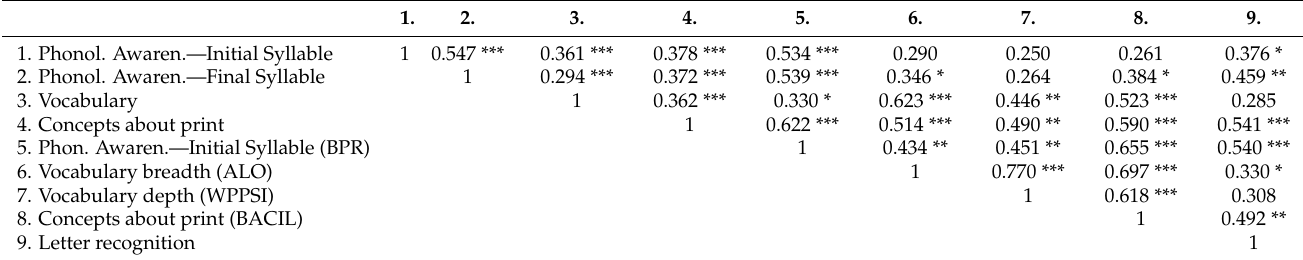
Table 6. Correlation matrix depicting correlations between all study variables (first grade group).